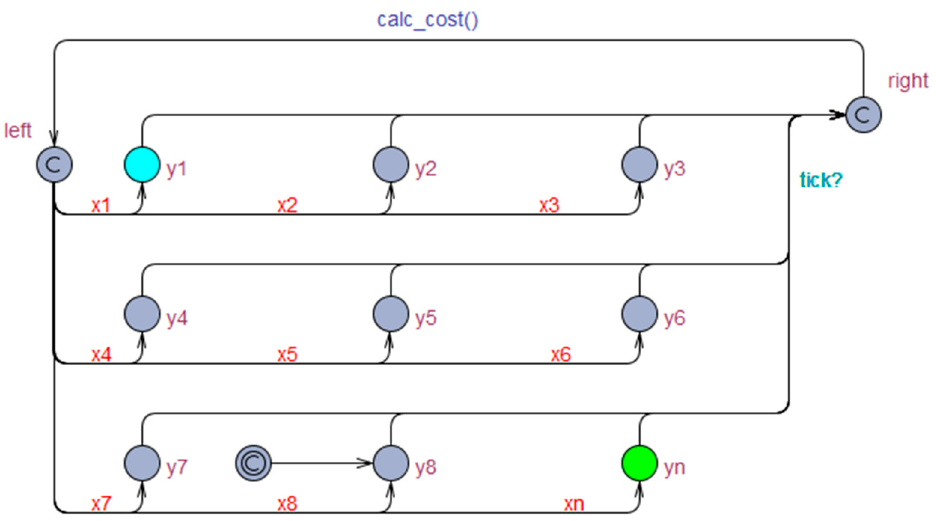
Figure 9. Abstract model of a controller in U PPAAL .